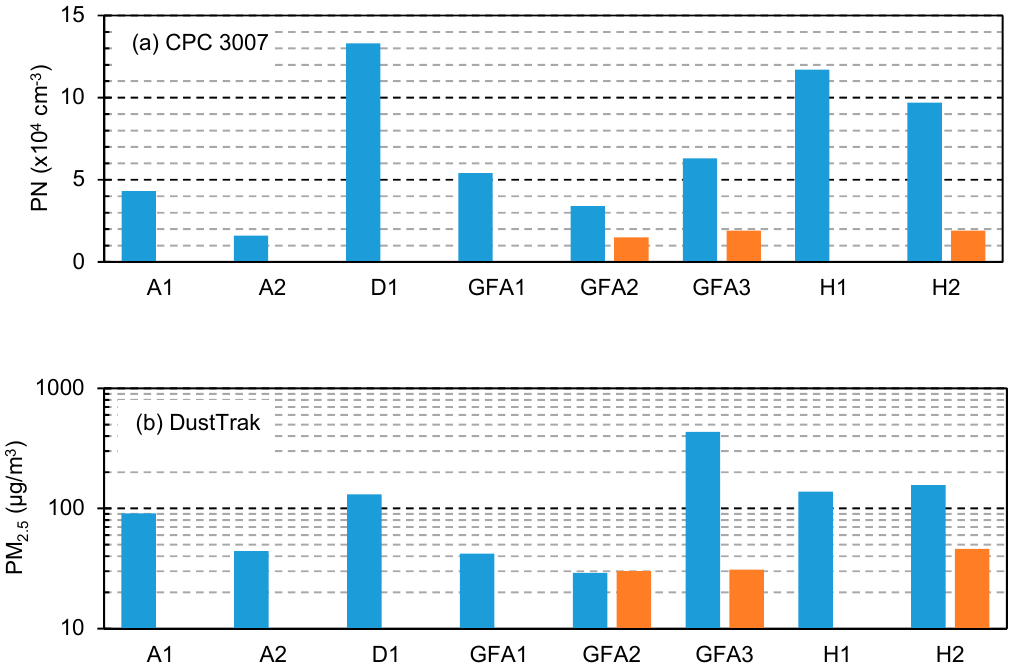
Figure 5. Overall mean indoor particle concentrations during the measurement period in each dwelling: ( a ) submicron particle number (PN) concentrations measured with the condensation particle counter (CPC 3007) and ( b ) PM 2.5 concentrations measured with the DustTrak. The blue bars represent the winter campaign and the orange bars represent the summer campaign. Table 4. Indoor particle number and mass concentrations (mean ± SD and 95%) during the winter campaign.